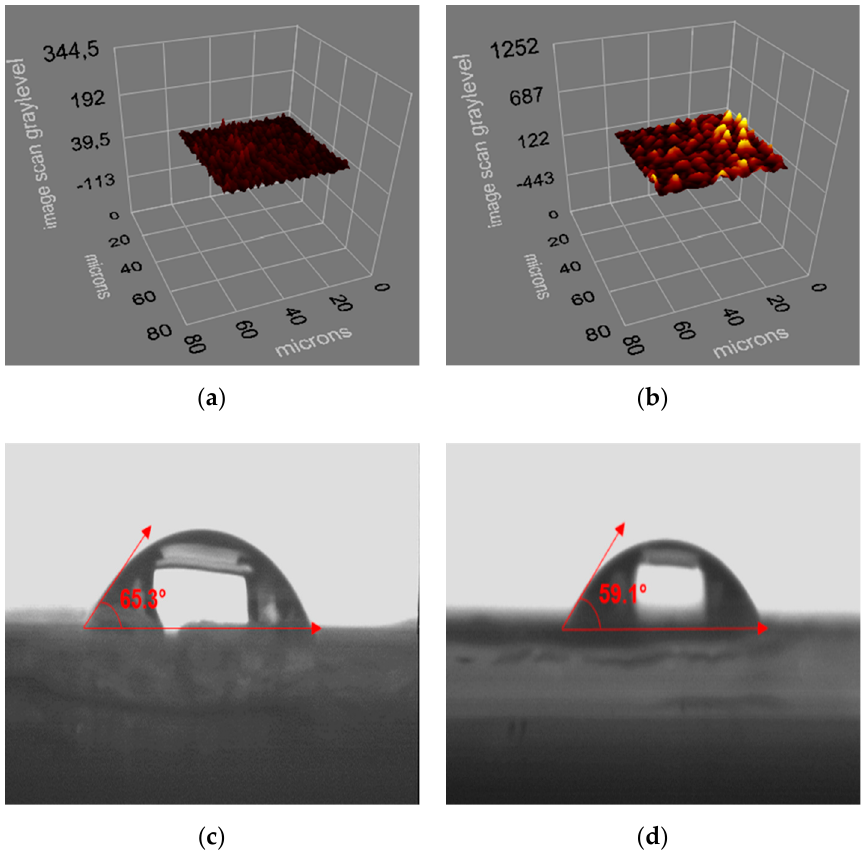
Figure 4. Sensor characterization results: Ellipsometry and contact angle images of ( a , c ) imprinted and ( b , d ) non-imprinted.